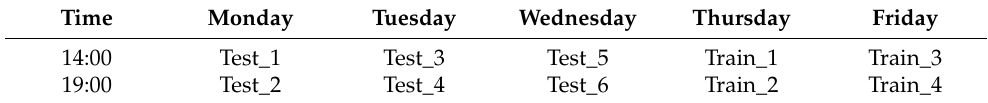
Table 1. Weekly data collection time.